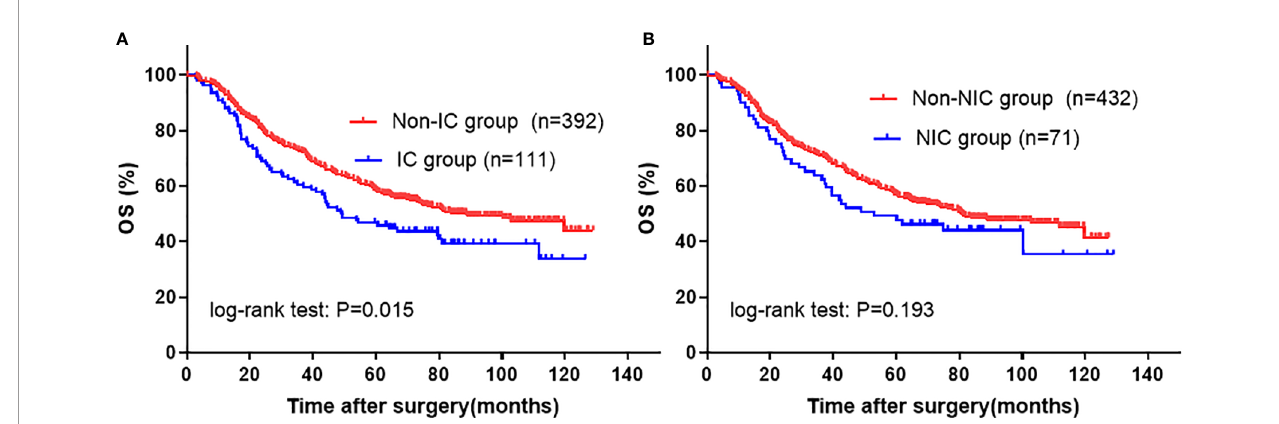
FIGURE 5 | Kaplan-Meier survival analysis according to speci fi c SC in PSM cohort. (A) ICs; (B) NICs. The signi fi cance of the difference between survival curves was calculated by the log-rank test. SC, severe complication; IC, infectious complication; NIC,